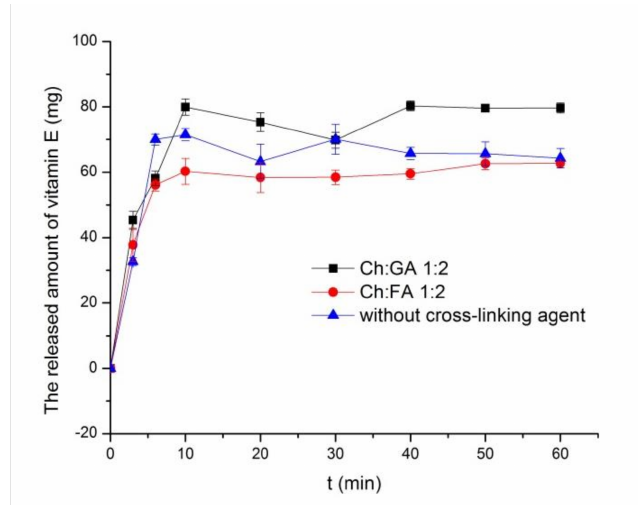
Figure 7. Release profiles of vitamin E from Ch/SDS-based microcapsules.